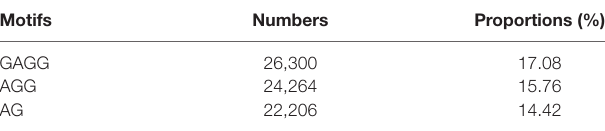
TABLE 1 | Details of the three motifs in positive